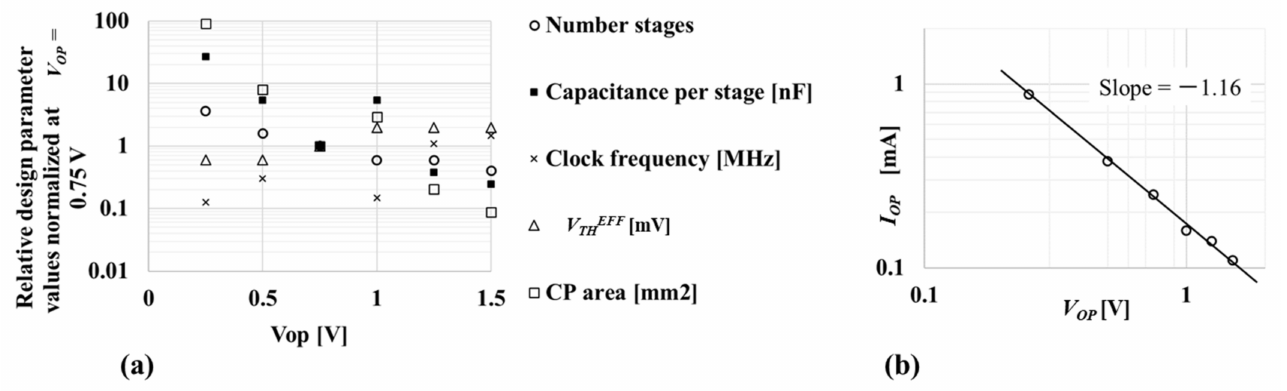
Figure 12. Trend of optimum design parameters ( a ) and I OP ( b ) across Vop .